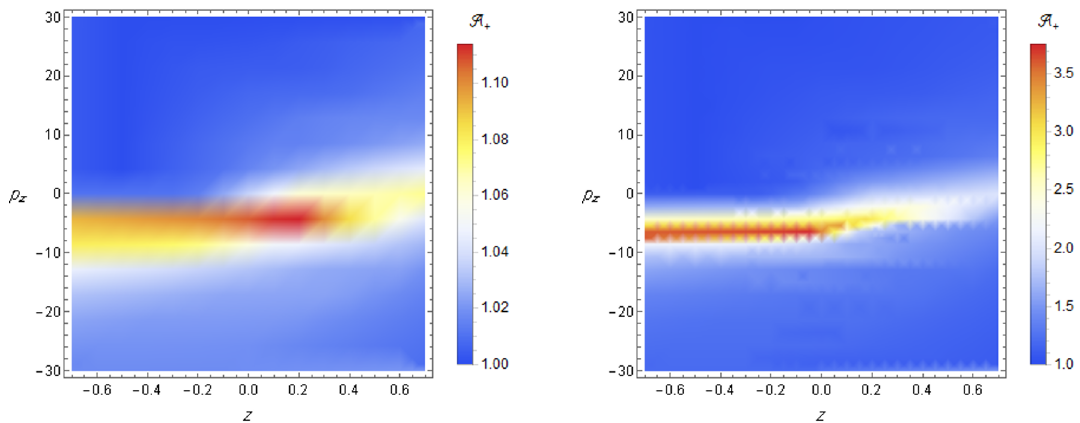
Figure 3 . For two bubble velocities, v w = 0 . 01 (left figure) and v w = 0 . 1 (right figure), the factor A + for DM particles is displayed. Since to obtain the observed relic abundance, it requires ∆ θ (cid:28) 1 and hence since A + and A − are displayed almost the same, A + is only